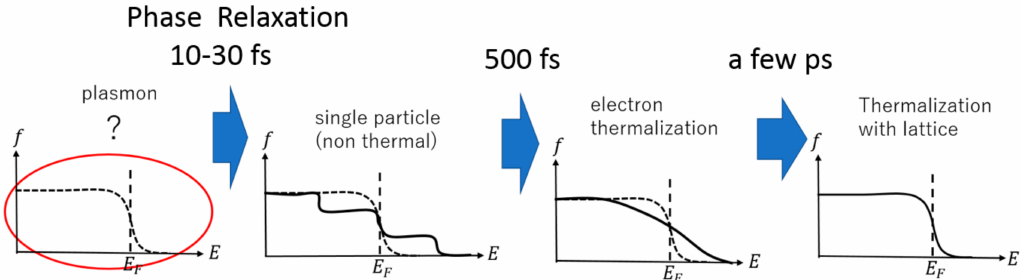
Figure 1. Change in the electronic distribution expected after plasmon excitation (dashed lines: Fermi distribution